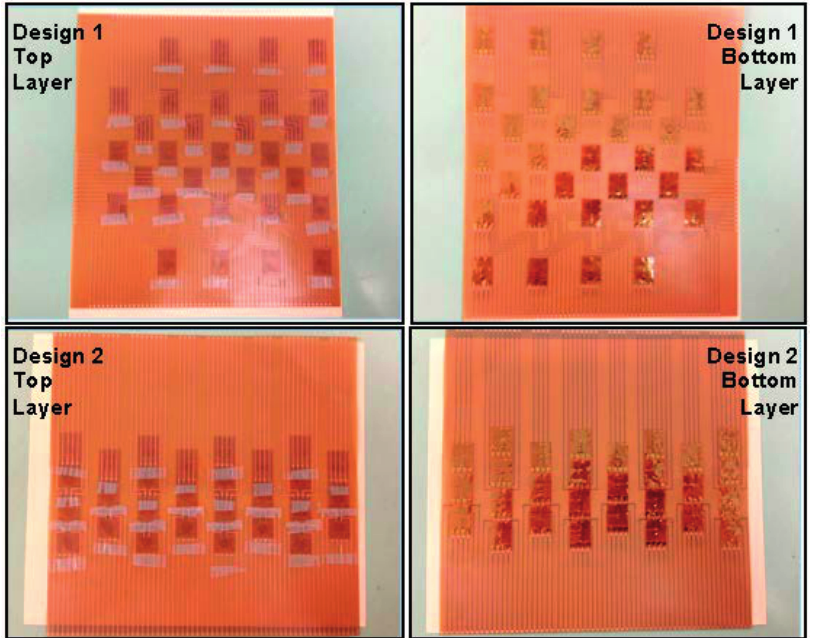
Figure 8. Complete assembly of top layer (left two images) and bottom layer (right two images) of two sensing sheet designs; Design 1 is shown in the two upper photographs and Design 2 is shown in the two lower